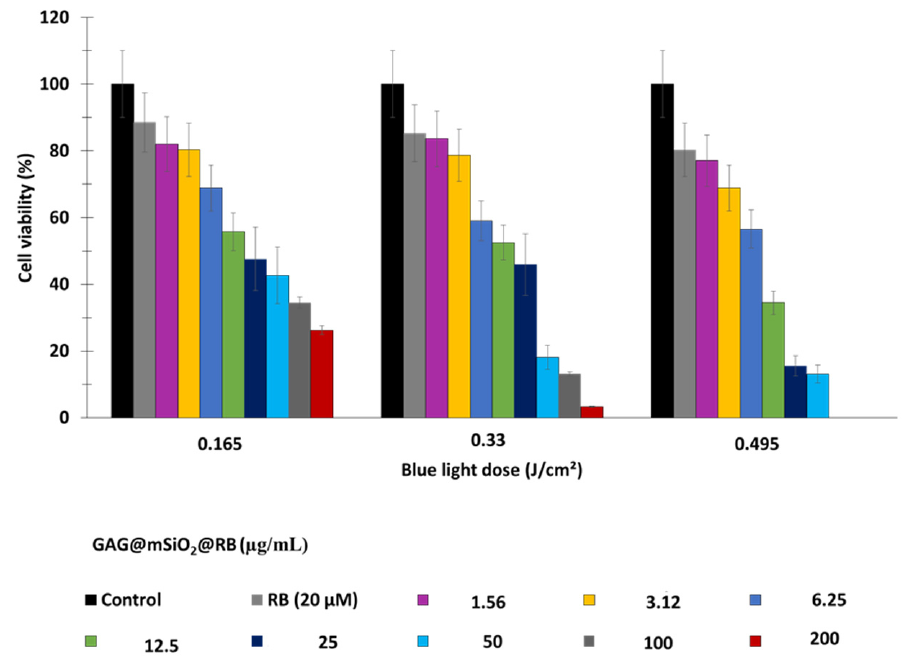
Figure 26. Cell viability of MDA-MB-231 cells upon exposure to irradiation (470 nm, 20 mW/cm 2 ) for 15 min, 30 min and 45 min corresponding to energy densities of 0.165, 0.33, and 0.495 J/cm 2 , respectively. Adapted from Jain et al. [60].